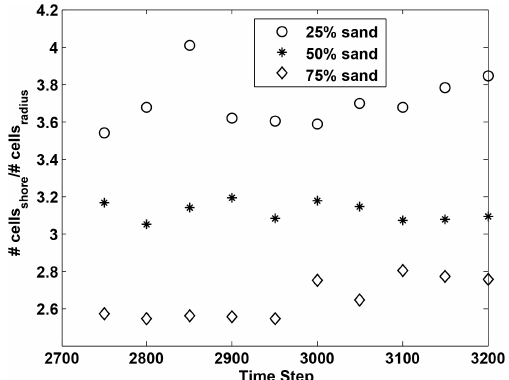
Figure 7. Comparing shoreline roughness between simulated deltas with input sand fractions of 25, 50, and 75%. Shoreline roughness here is measured by the ratio between (i) the number of cells in the domain that contain a piece of shoreline of the simulated delta, and (ii) the average radius of the delta toposet in number of